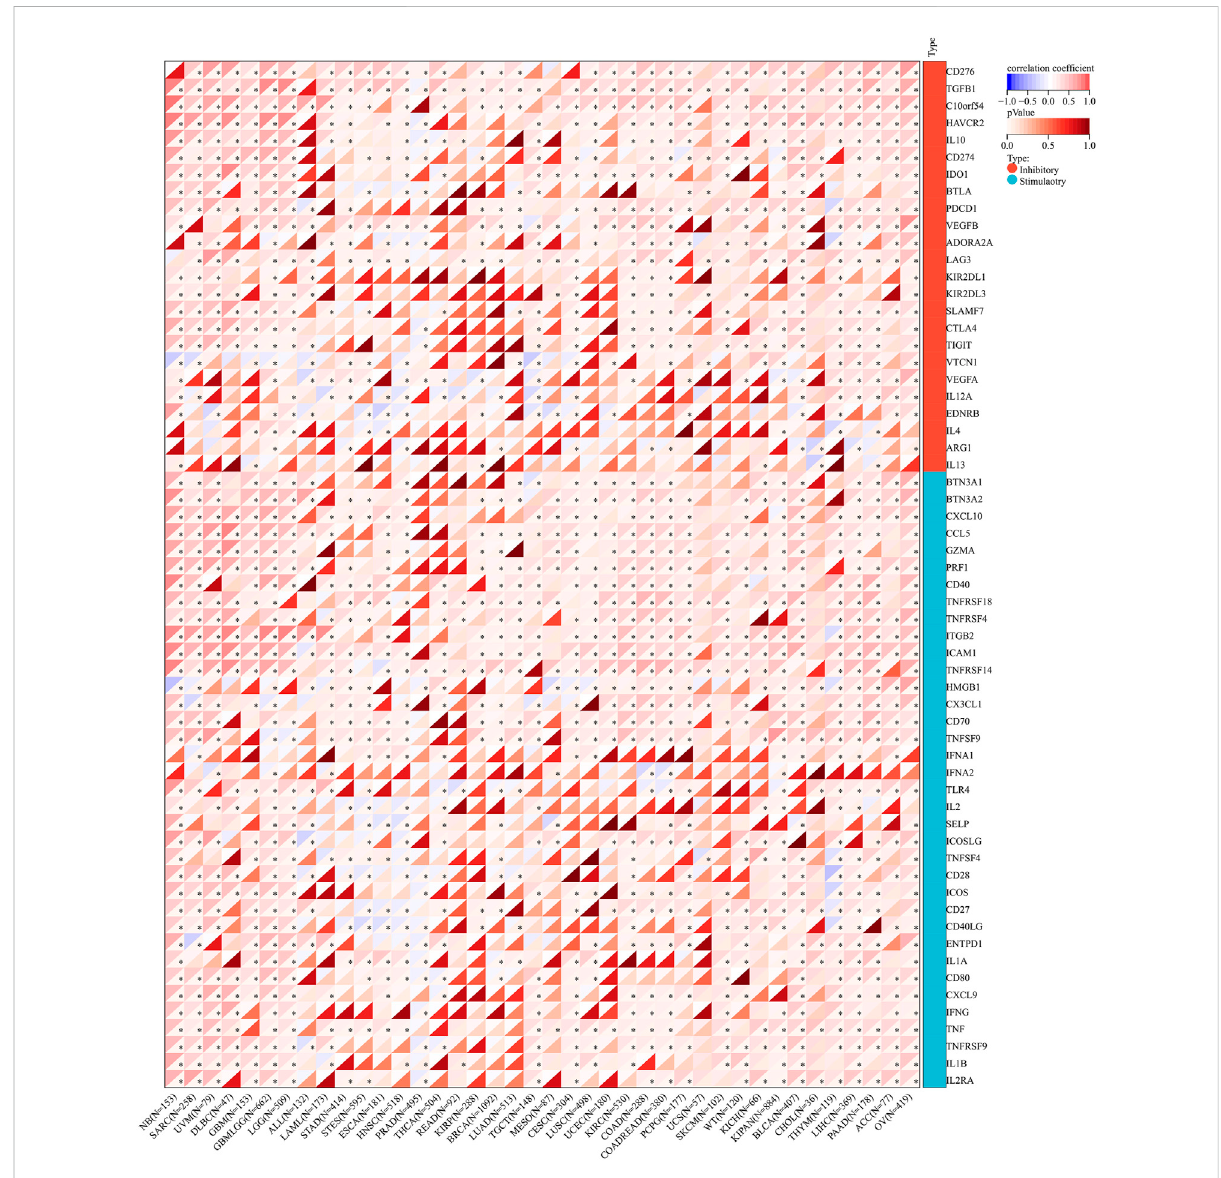
FIGURE 10 Analysis of correlation between the expression of AGTRAP and immune checkpoint